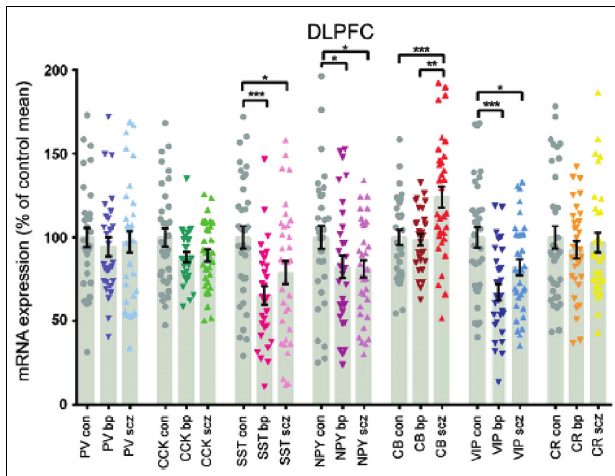
FIGURE 6 |The interneuron protein marker calbindin is elevated in schizophrenia, but bipolar subjects do not differ from controls (Fung etal., 2014).